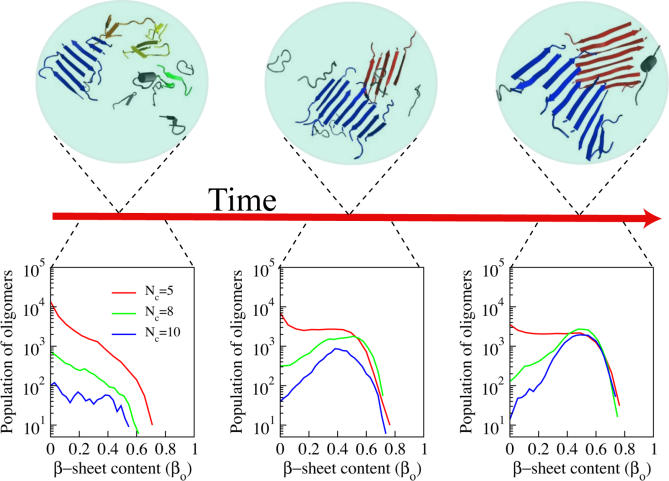
Time Dependence of the Population of Aβ25–35 OligomersThe population P(Nc) was calculated as the sum over all the oligomers of a given size (Nc = 5 (red), 8 (green), and 10 (blue)) in a specific time window and in all the 100 independent simulations. We show P as a function of the β sheet content as defined by the local-order parameter βo. Each window corresponds to a different time point along the simulation. At early stages (left), only small ordered oligomers are present, while at intermediate stages (centre), the size of ordered oligomers grows, and at late stages (right), the ordered oligomers are quite large.